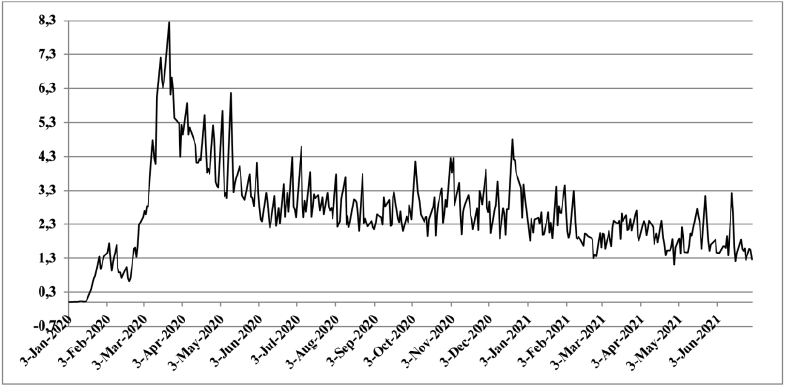
Figure 1: The trend of Covid-19 Panic Index from 1 st January 2020-30 th June 2021; Source: Author’s